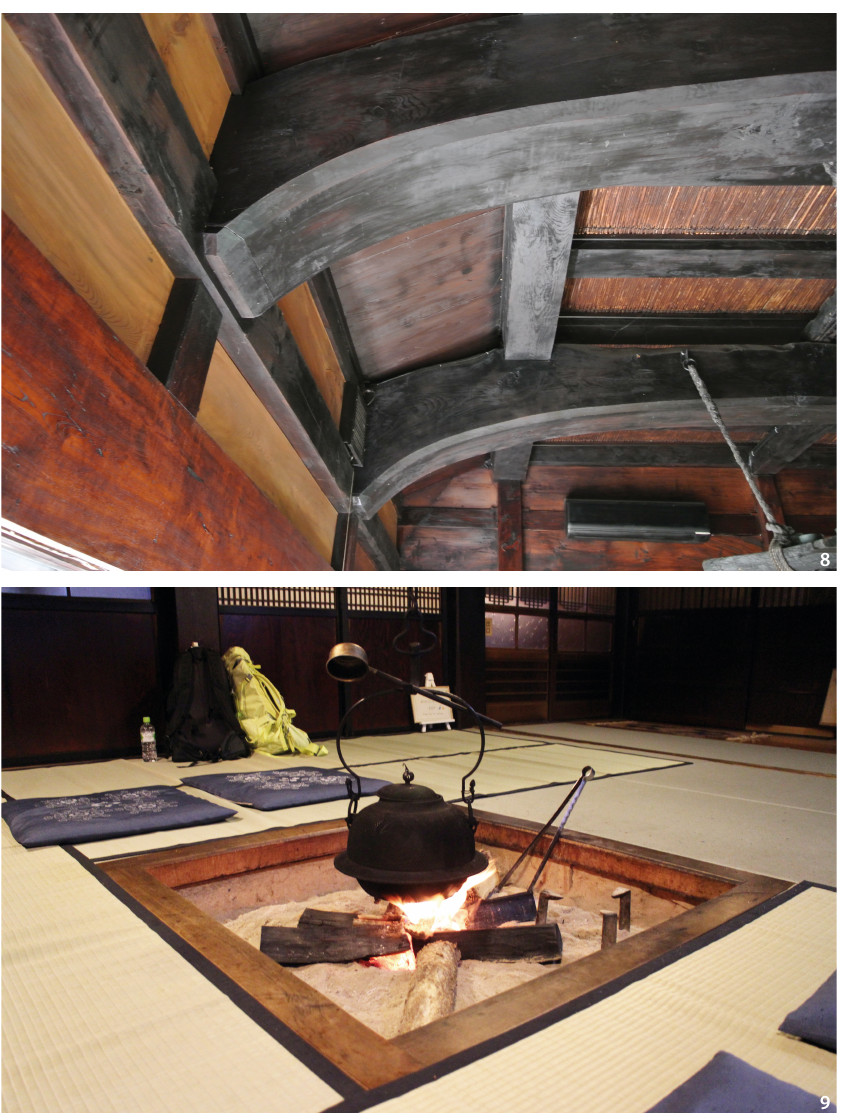
Figure 8 Chona-bari beam of a Gassho- style house: Snow-bent woods enhance the structure (Source: the author). Figure 9 Irori: Fireplace in a Gassho-style house (Source: the